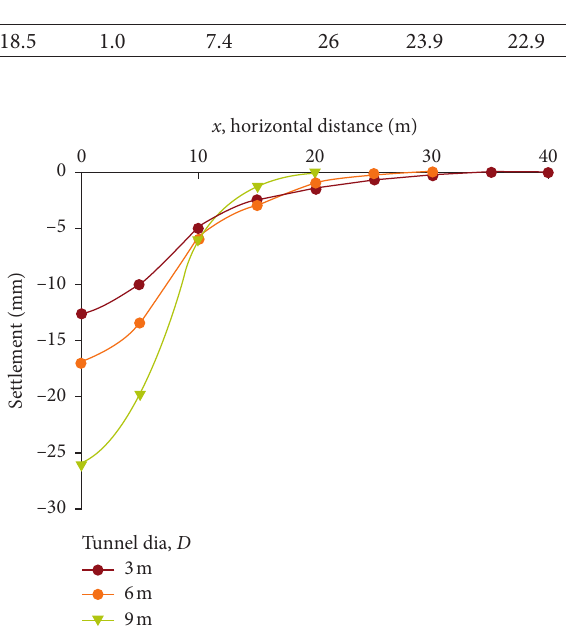
Figure 5: Settlement trough for different tunnel sizes. Surface settlement characteristics from tunnel centerline to outwards for 3 different tunnel diameters “ D